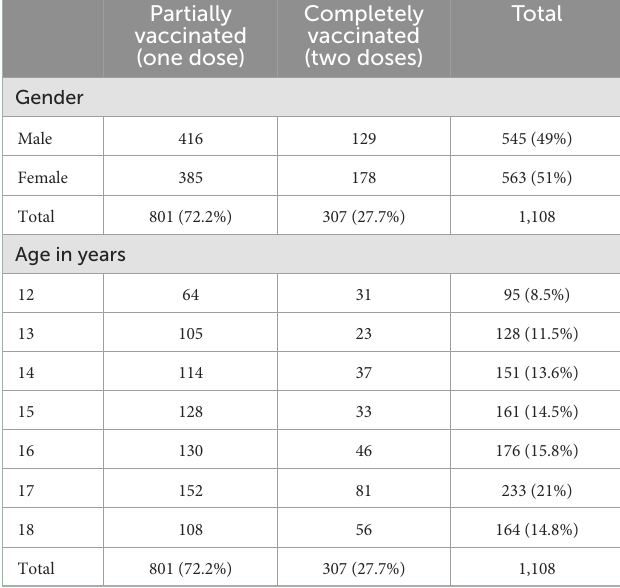
TABLE 1 Gender, age, and vaccination status of